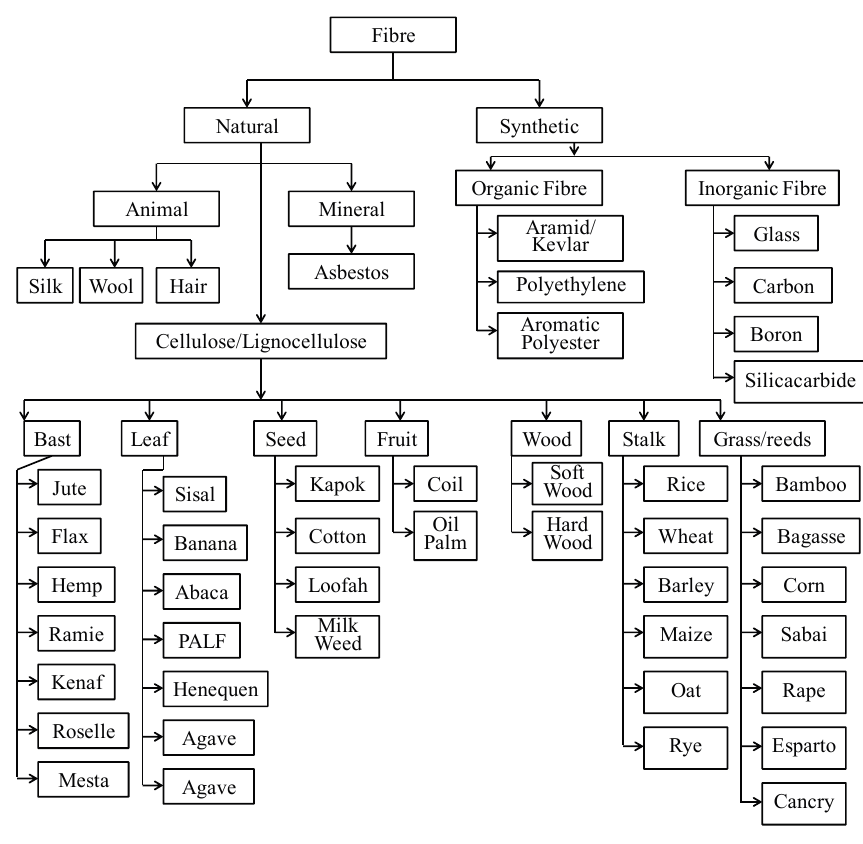
Figure 1. Classification of natural and synthetic fibers. Reprinted with permission from Elsevier, 2011